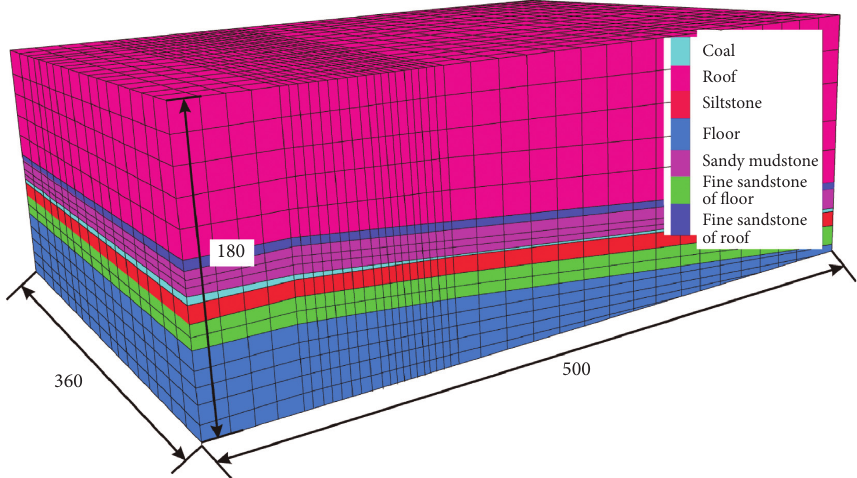
Figure 7: Model unit division and model size.